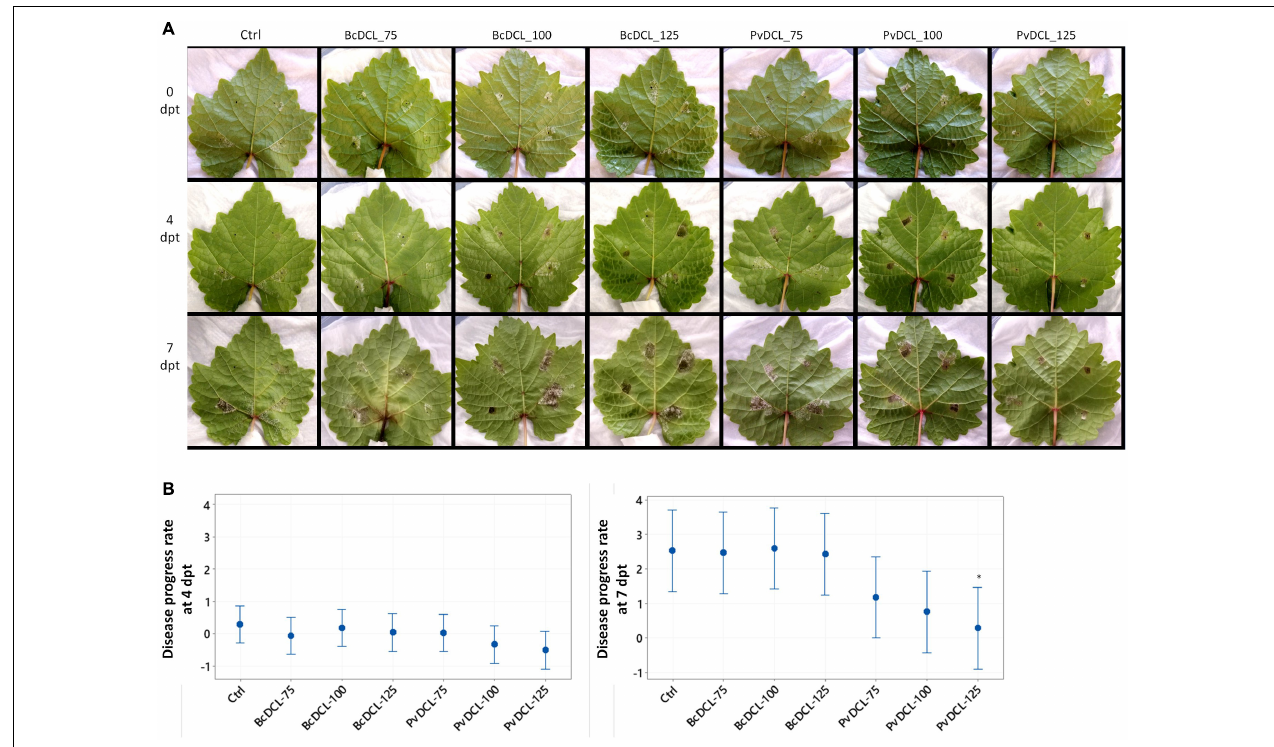
FIGURE 3 | Progress of Plasmopara viticola on g rapevine leaves after being treated with PvDCL1/2 double-stranded RNA (dsRNA). (A) Progress of already established P. viticola infection after receiving dsRNA treatments. Leaves were treated with 50 µ l of water (ctrl) or dsRNA [75, 100, or 125 ng µ l - 1 of dsRNA of BcDCL1/2 (BcDCL_75/100/125) or PvDCL1/2 (PvDCL_75/100/125)] 7 days after being inoculated with 7.5 µ l of a 1 × 10 5 ml - 1 sporangia [i.e., 0 days post treatment (dpt) of dsRNA]. (B) Disease progress rate at 4 and 7 dpt, computed by taking leaf area covered by P. viticola at 7 dpi (0 dpt) as a reference. Bars are 95% confidence interval, and asterisks ( ∗ ) indicate statistically significant differences according to Tukey’s honestly significant difference test ( P ≤